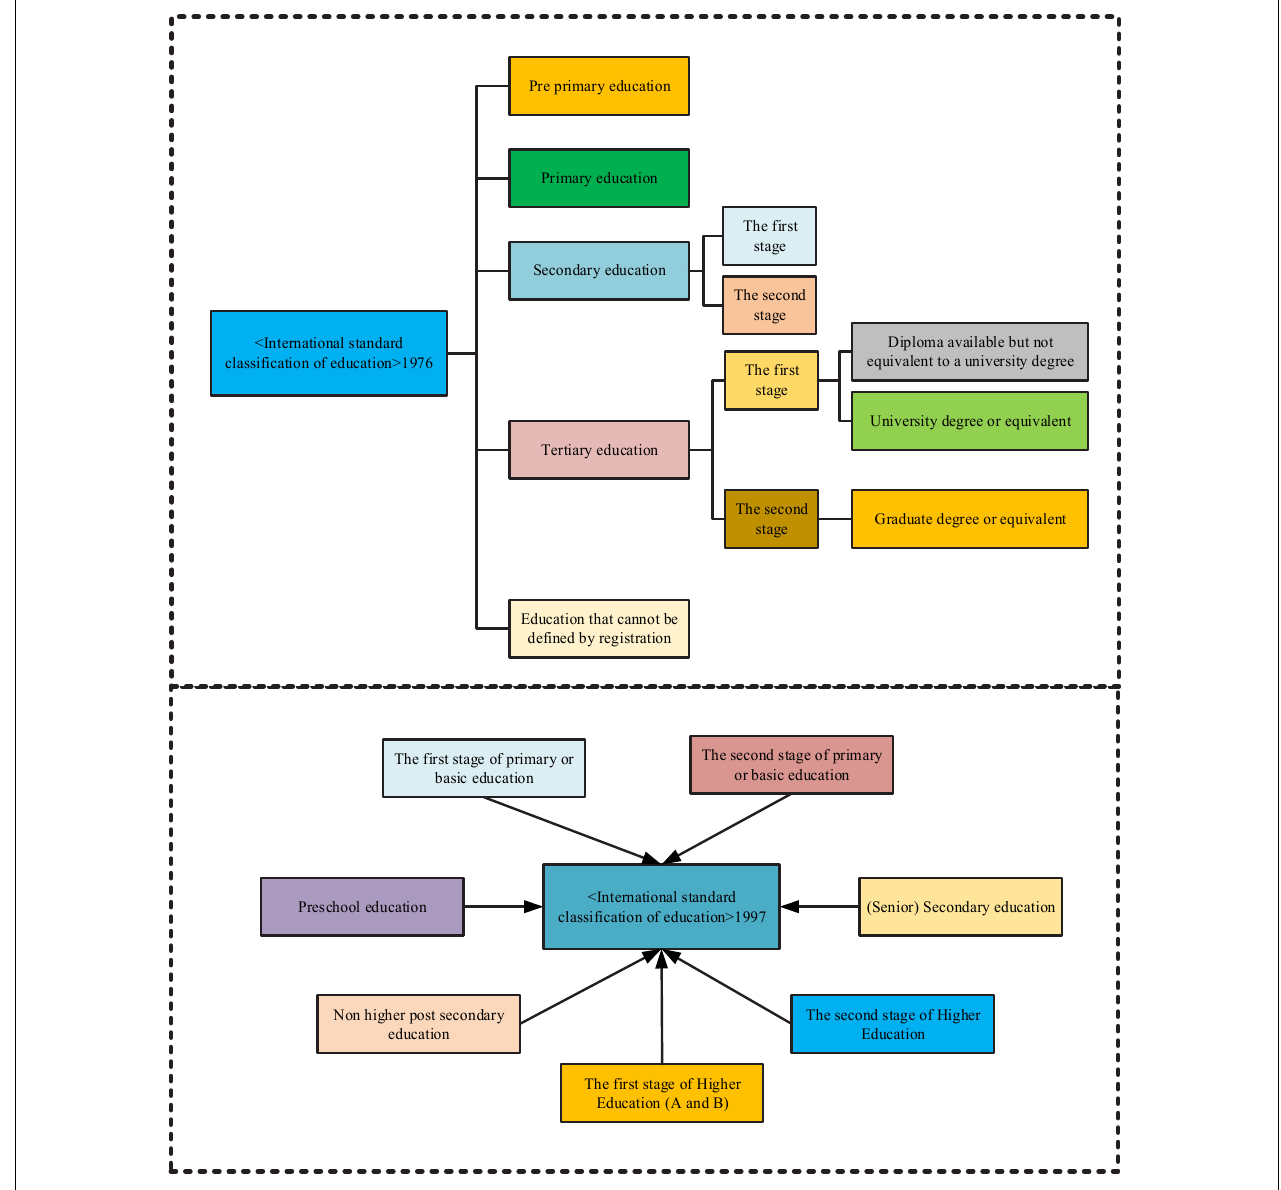
FIGURE 1 | International standard classification of